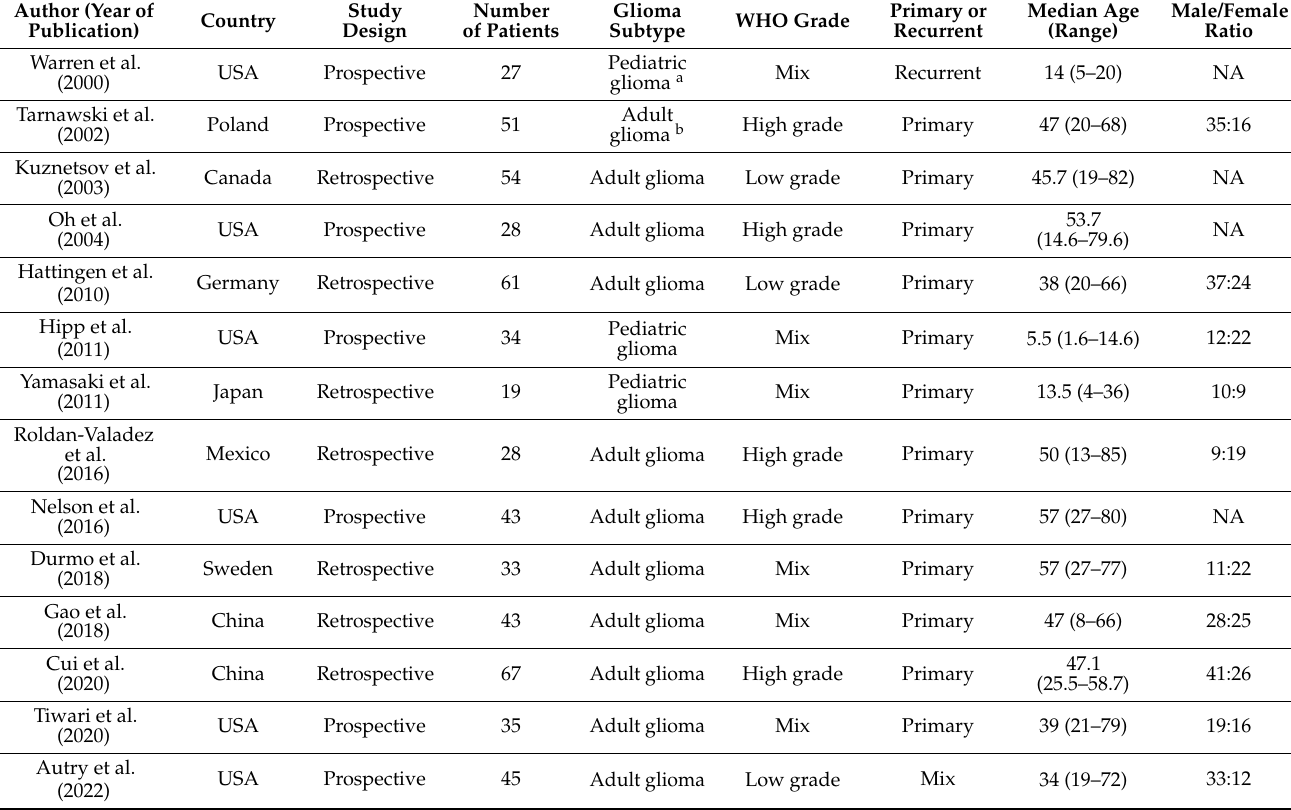
Table 1. Study and patient characteristics of the selected